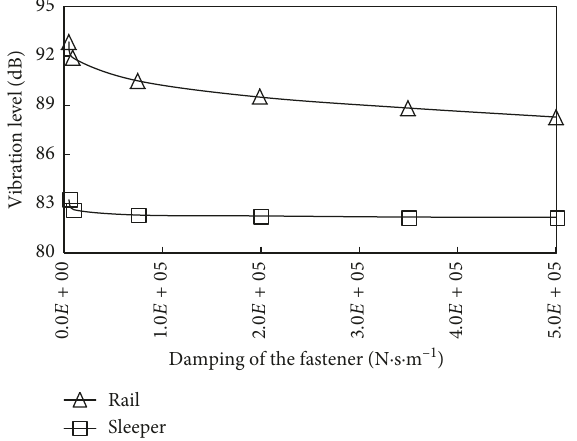
Figure 9: The influence of damping of fastener on the vibration power level. Figure 11: The influence of damping of the rubber pad on the vibration power level.